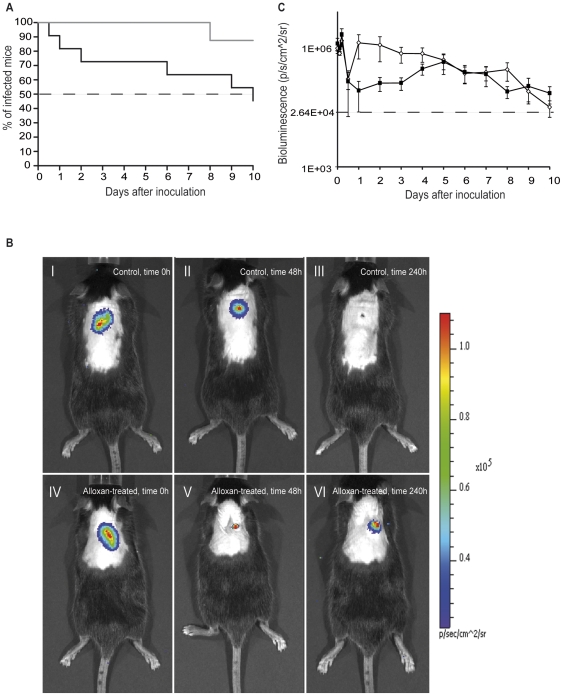
Impaired bacterial clearance in alloxan-induced diabetic mice.
A, Clearance rate of bioluminescent Staphylococcus aureus (1×107 CFU/ml) in control (black, n = 11) and alloxan-induced diabetic mice (grey, n = 9) until 50% of the control mice were cleared (dashed line). B, Representative images of bioluminescent S. aureus infected regions in control (upper panel) and alloxan-induced diabetic mice (lower panel) directly post inoculation (I and IV), and 2 (II and V) and 10 days (III and VI) post inoculation. C, Total bioluminescence in control (black, n = 11) and alloxan-treated (white, n = 9) mice over time. The dashed line represents average background bioluminescence. Data are means ± SEM.